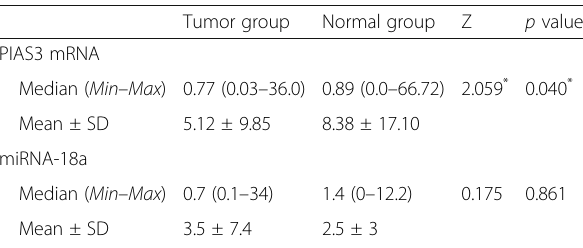
Table 2 PIAS3 mRNA fold expression and miRNA-18a fold expression in the studied groups